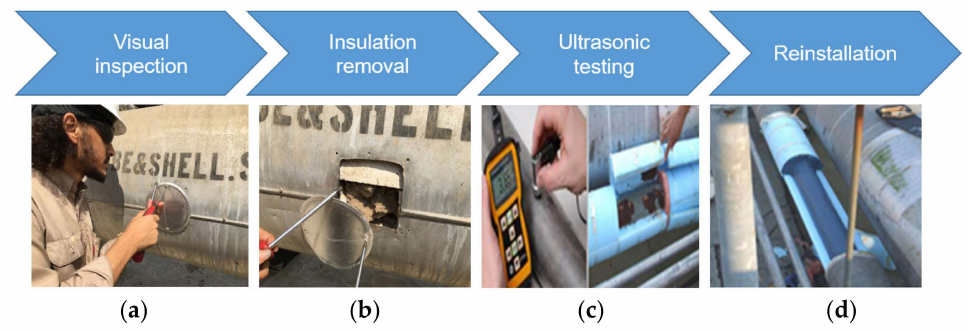
Figure 6. Four major steps involved in a CUI inspection process: ( a ) visual inspection, ( b ) partial or complete removal of insulation, ( c ) ultrasonic testing and ( d ) reinstallation of insulation material. Reprinted with authors’ permission from Ref.